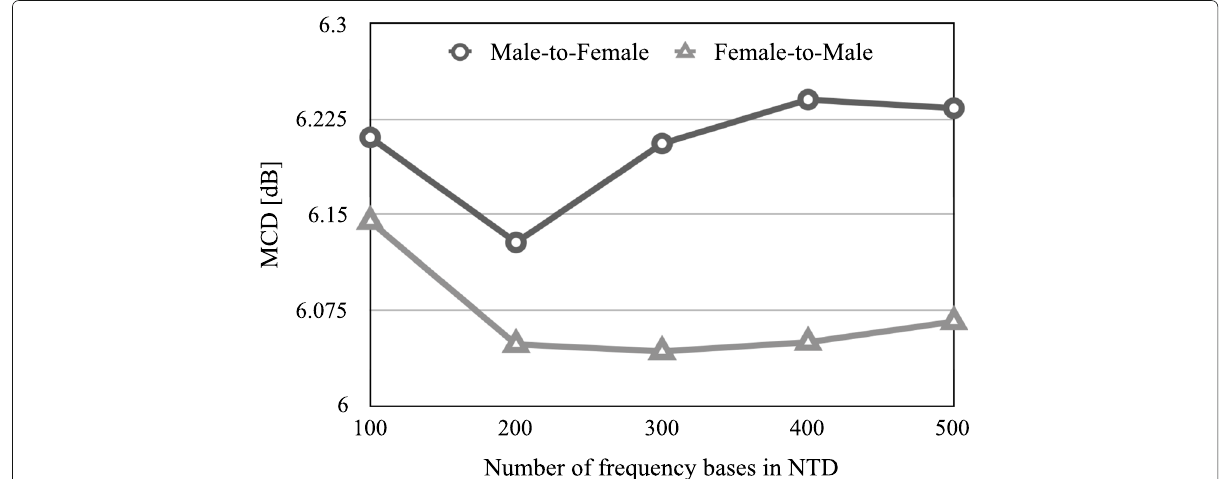
Fig. 5 Average MCD [dB] of the conventional NTD-based VC when varying the number of frequency bases